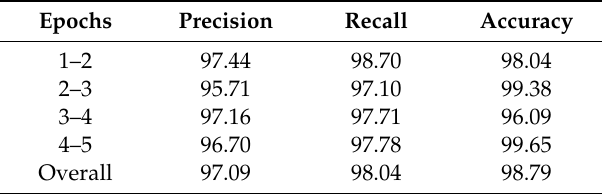
Table 3. Precision, recall, and accuracy of the automated redundant surface